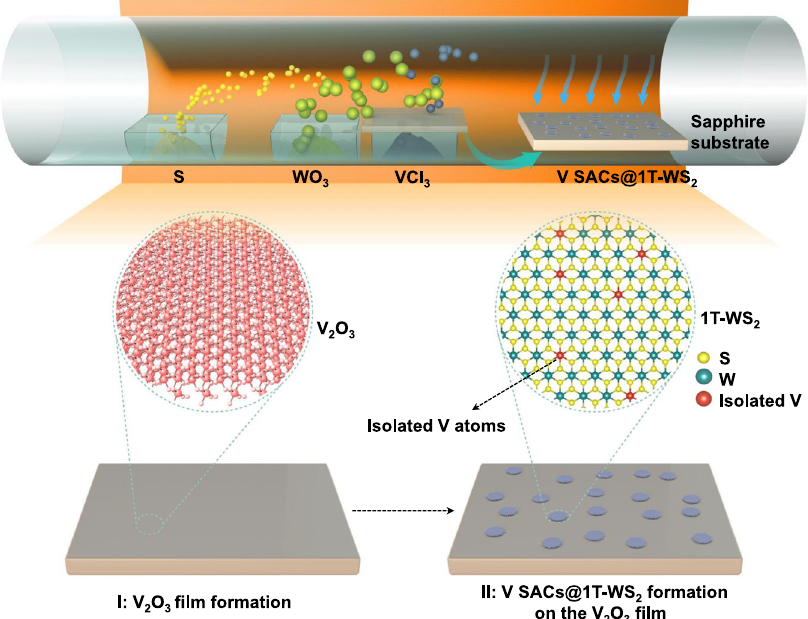
Fig. 1 Schematic illustration of the synthetic process for V SACs@1T-WS 2 monolayers. I V 2 O 3 formation in the early growth stage. II V SACs@1T-WS 2 monolayers formed on the V 2 O 3 fi